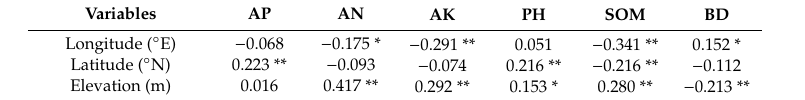
Table 5. Pearson correlations between site conditions and soil factors on a logarithmic (ln) scale. Variables AP AN AK PH SOM BD Longitude ( ◦ E) − 0.068 − 0.175